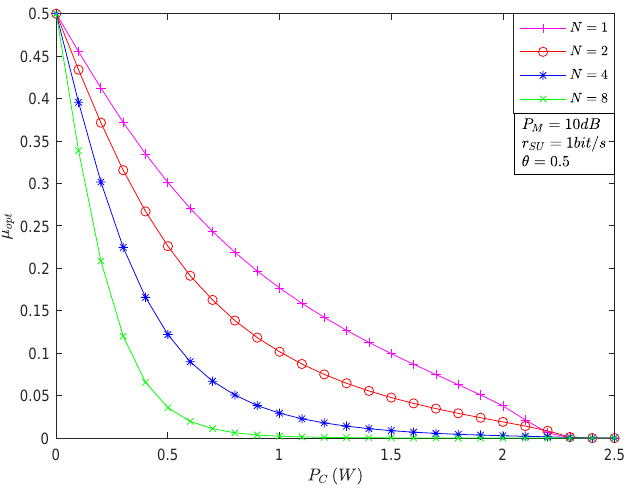
Figure 3. The optimal EDP versus P C for the different number of relays.